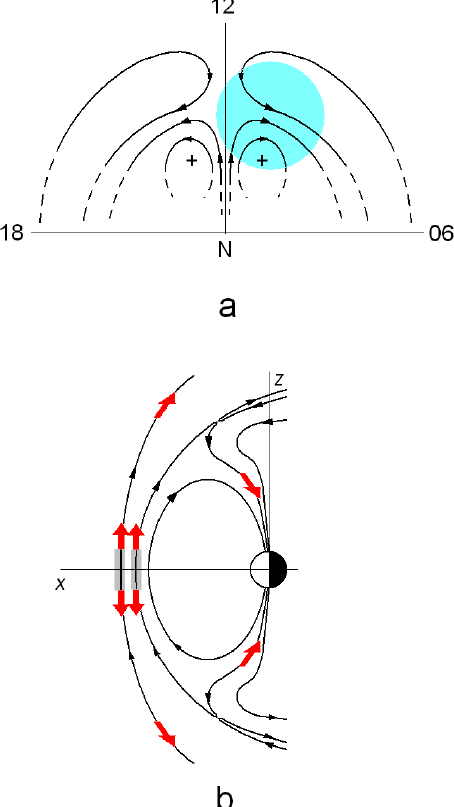
Fig. 9. Sketches showing the main features of reconnection un- Fig.9. Sketches showing the main features of reconnection under negative IMF Bz: (a) four-cell der negative IMF B z : (a) four-cell convection pattern in the iono- convection pattern in the ionosphere; (b) capturing of anisotropic plasma from the sphere; (b) capturing of anisotropic plasma from the magnetosheath magnetosheath and penetration of magnetosheath Pc1s to the near-cusp ionosphere. The green and penetration of magnetosheath Pc1s to the near-cusp ionosphere. circle indicates the field of view of TV camera in Barentsburg; grey areas are magnetosheath The green circle indicates the field of view of TV camera in Bar- entsburg; grey areas are magnetosheath ions; red arrows show the ions; red arrows show the propagation of the EMIC waves. propagation of the EMIC